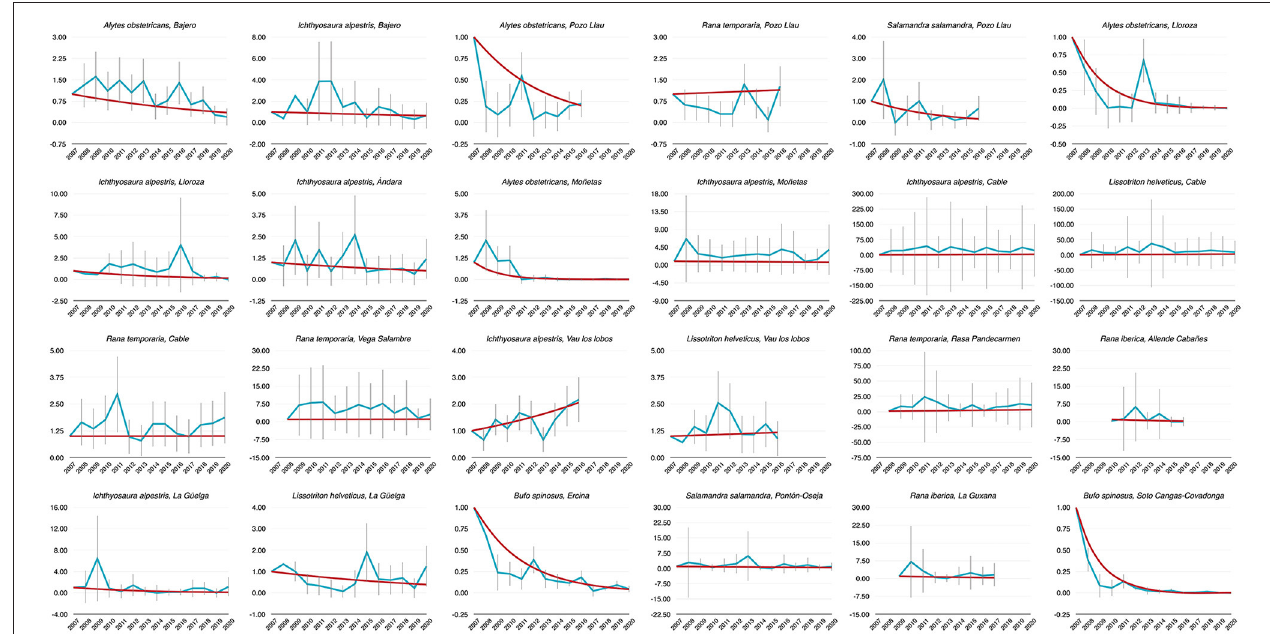
FIGURE 1 | Dynamics of abundance of 24 populations of PNPE estimated from 2007 to 2020. Time index 1 refers to the amphibian counts measured in 2007 (i.e., the baseline in first sampling year). Blue lines are annual abundance estimates, while red lines were established by means of TRIM models.